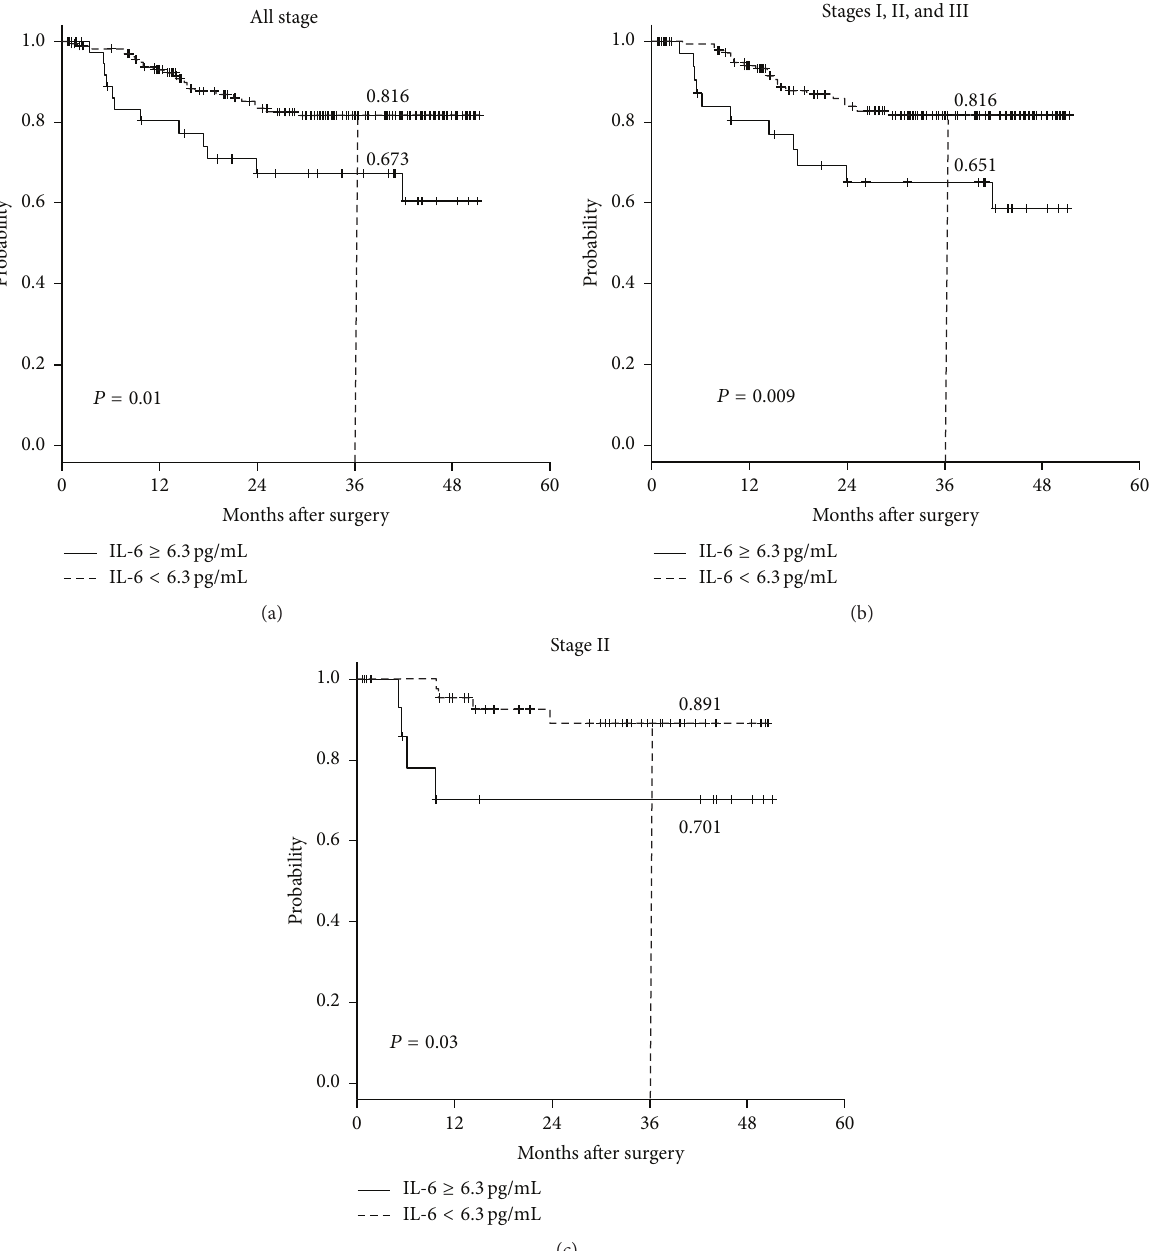
Figure 3: Disease-free survival (DFS) rates according to the preoperative serum interleukin-6 (IL-6) status. (a) DFS of all 207 patients who underwent curative resection. (b) DFS of 188 patients with stages I–III colorectal cancer. (c) DFS of the 60 stage II